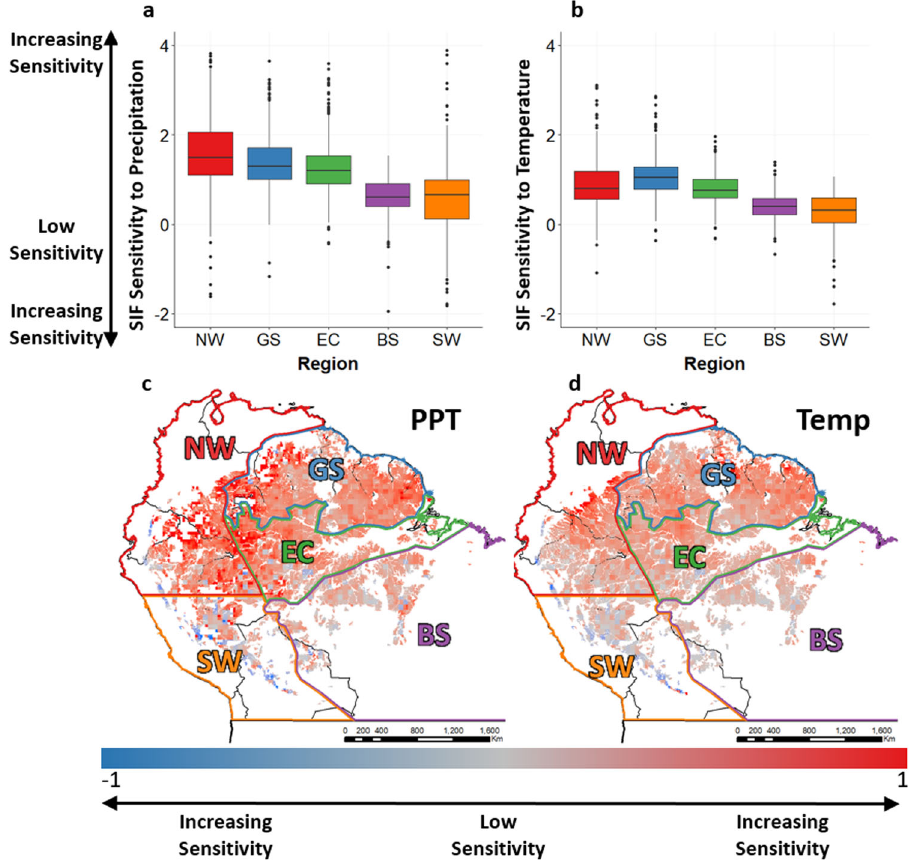
Fig. 3 Spatial distribution and regional averages of SIF sensitivity to temperature and precipitation anomalies. a , b Show precipitation ( a ) and temperature ( b ) regionally averaged sensitives. SIF Sensitivity is calculated as Log 10 (Standardised SIF Anomaly /Standardised PPT Anomaly) and Log 10 (Standardised SIF Anomaly/Standardised Temp Anomaly) respectively. Box plot centre line, top, and bottom line represent the median, 75th, and 25th percentile, respectively. Upper and lower whiskers represent the largest and smallest value within 1.5 times the interquartile range above and below the 75th/25th percentile respectively. Results are split by geographical regions established by Feldpausch et al. 44 . c , d Spatial distribution of SIF sensitivity to precipitation ( c ) and temperature ( d ). Sensitivity was calculated only for pixels that represented, negative precipitation, and positive temperature anomalies respectively. Temperature sensitivity has been inverted to aid in visual